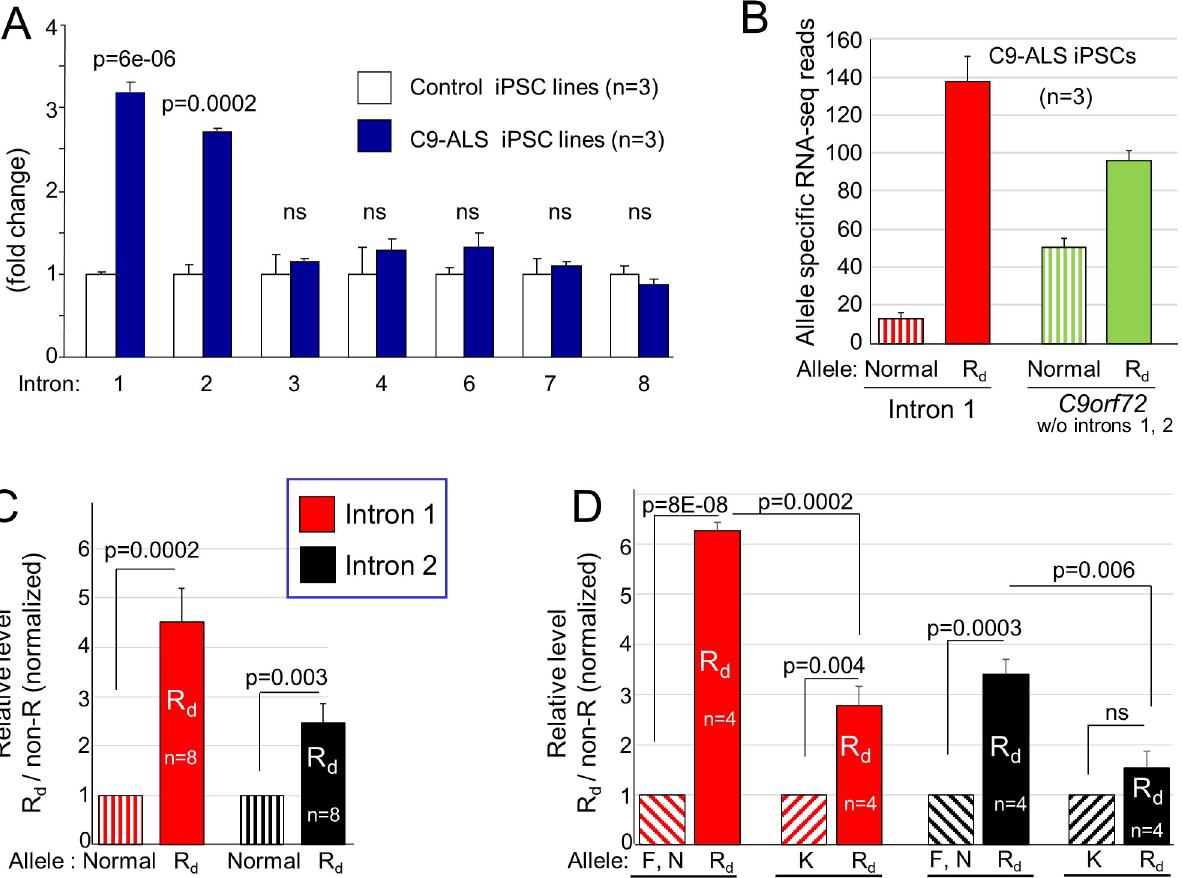
Fig 3. Association between HR length and introns 1 and 2 levels. (A) The relative frequency of RNA-seq reads aligned to C9orf72 introns in control (white) and C9-ALS (blue) iPSC lines. Intron reads from each iPSC line were normalized to those of exons 2–5. Data represented as fold-change versus control iPSCs. (B) RNA-seq reads of C9-ALS iPSCs that overlap with heterozygous SNP sites are identifiable from their allelic origin from either the normal (dashed columns) or R d (solid columns) allele. Identifiable reads within intron 1 are depicted in red, and within other C9orf72 regions (without intron 2) in green. (C) Allelic ratio in introns 1 and 2 of C9-ALS fibroblasts determined by Sanger sequencing of RT-PCR amplicons, which was normalized to the ratio in C9orf72 exons. (D) The results in (C) displayed separately for the R d K fibroblasts (n = 4) and for other C9-ALS fibroblasts (R d F and R d N; n = 4). Data presented as mean ± SEM. ns: